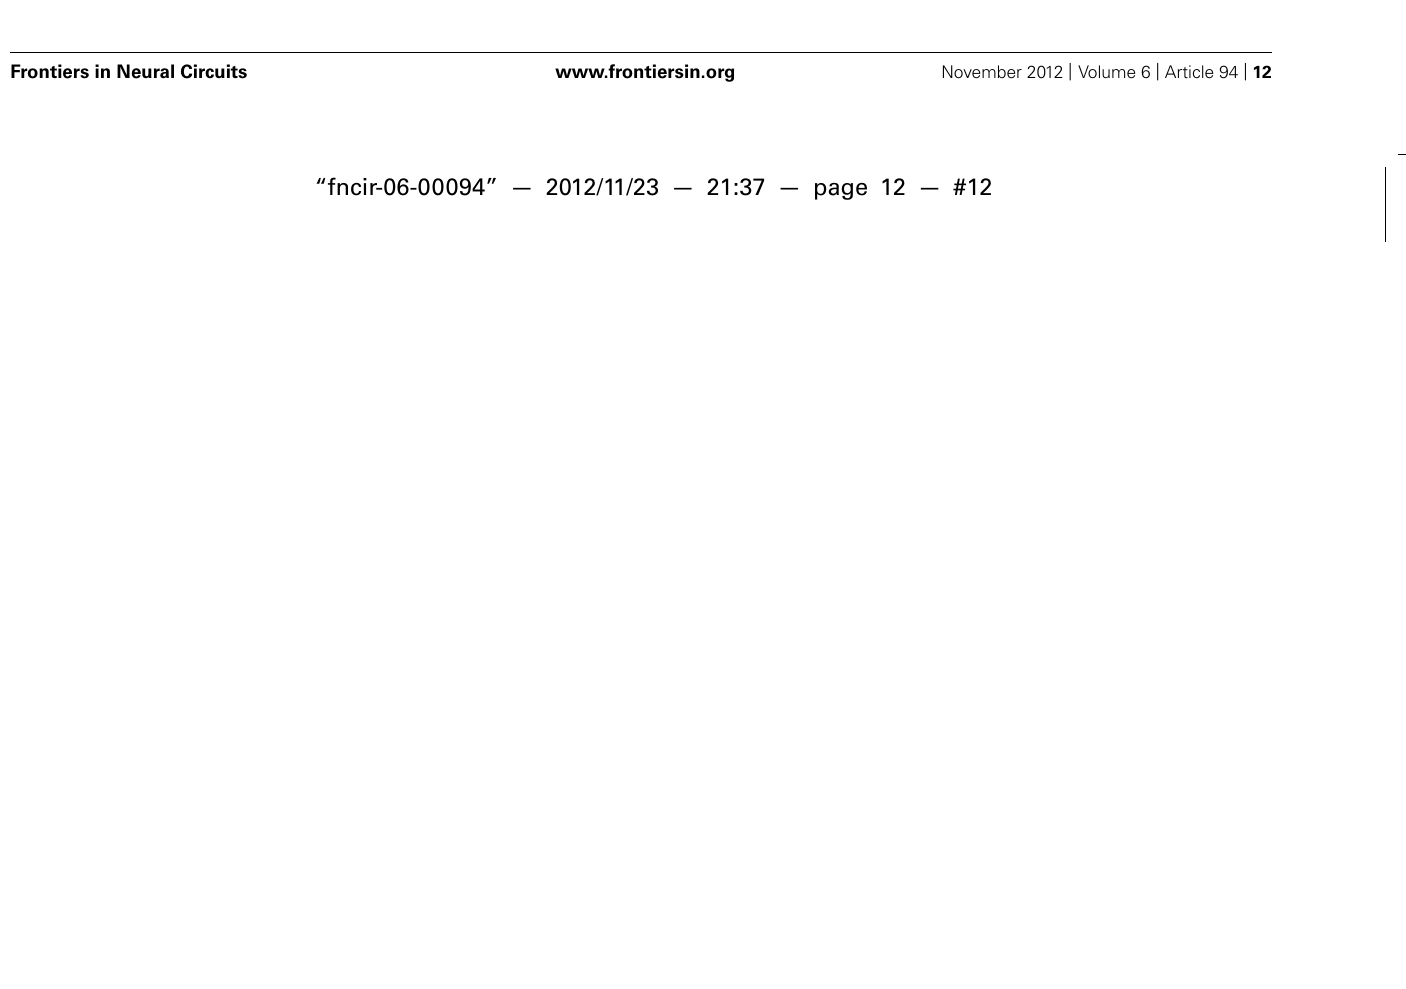
FIGURE 8 | Different effects of CLZ and MDZ at low nanomolar concentrations: a states analysis. Data obtained from the same network on which increasing concentrations of CLZ (A–D ) or MDZ (E–H ) were applied after a 3-h wash-out; the wash-out II lasted 12 h and data displayed are for each hour. In the upper and lower panels, excitatory (red) and inhibitory (black)